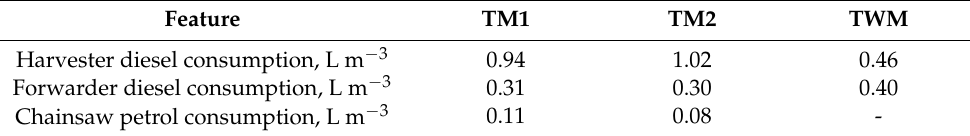
Table 6. Fuel consumption by Vimek 404 T5 harvester, Vimek 606 TT forwarder, Husqvarna 346 XP.